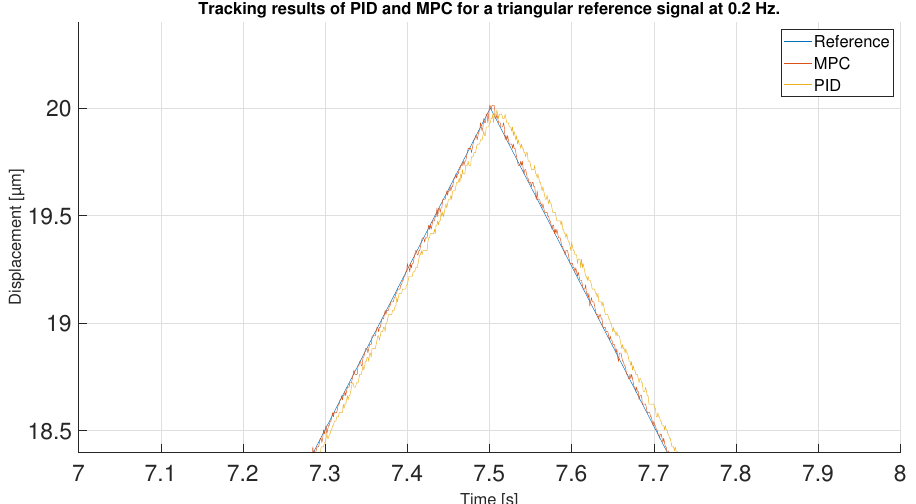
Figure 18. Zoom of tracking results in 0.2 Hz triangular signal peak.